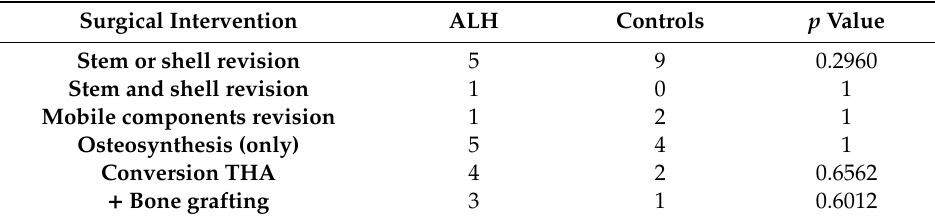
Table 3. Type of surgical intervention.